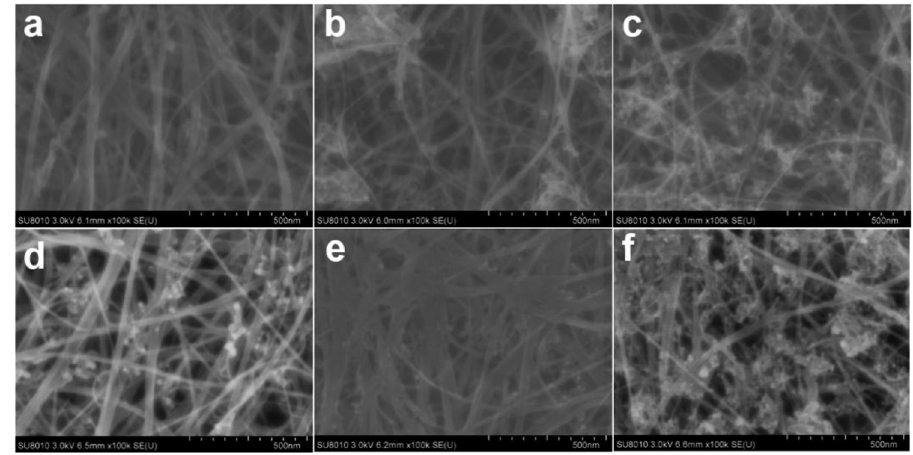
Figure 6: SEM micrographs of CNT fi lms with higher magni fi cation: ( a ) PCNT, ( b ) NC - 1, ( c ) NC - 2, ( d ) EC, ( e ) HC, and ( f ) HNC -